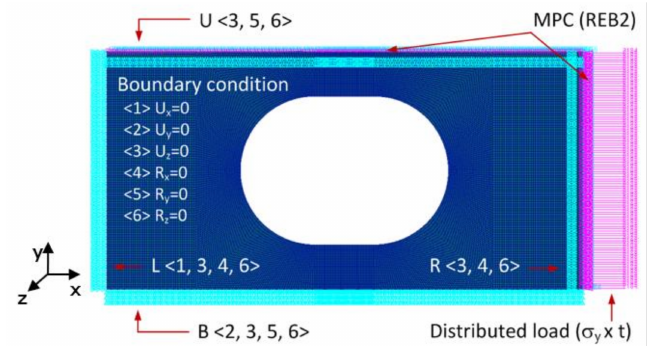
Figure 4. Loading and boundary conditions of the perforated plate.